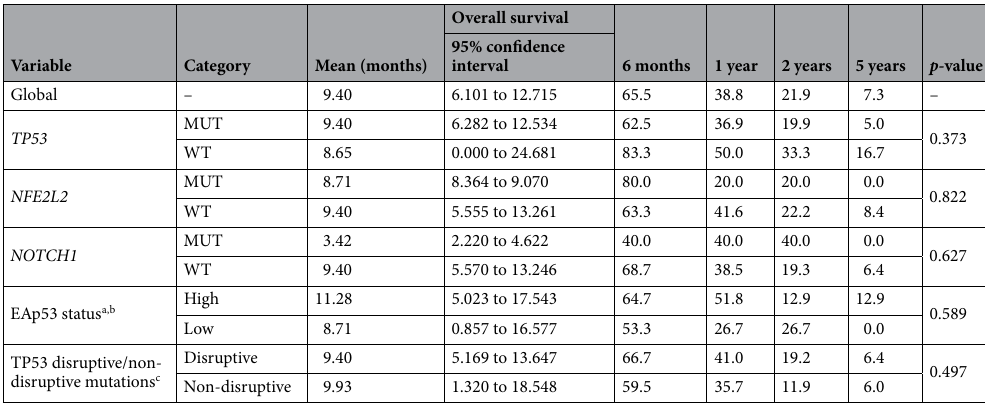
Table 5. Estimation of Global Survival by the Kaplan–Meier method considering patients’ time follow-up and mutation status and multivariable survival analysis (Cox regression model). n number of variants. a http:// High-Risk Mutations Associated with Decreased Survival and Increased Distant Metastases in Head and Neck Cancer, Cancer Res. 2015 Apr 1;75(7):1527–36. c Poeta et al. TP53 mutations and survival in